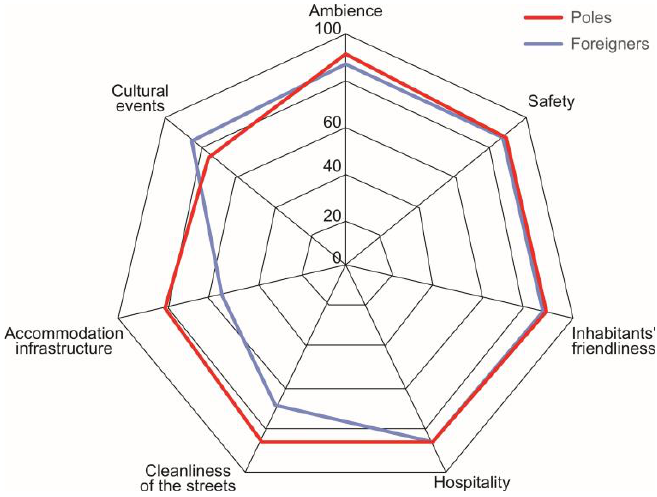
Figure 8. Top-rated aspects of WYD in the Archdiocese of Lodz (the total of “good” and “very good”) (Source: authors, based on a